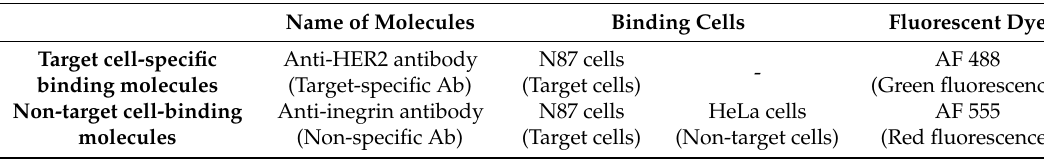
Table 2. Antibodies used in the